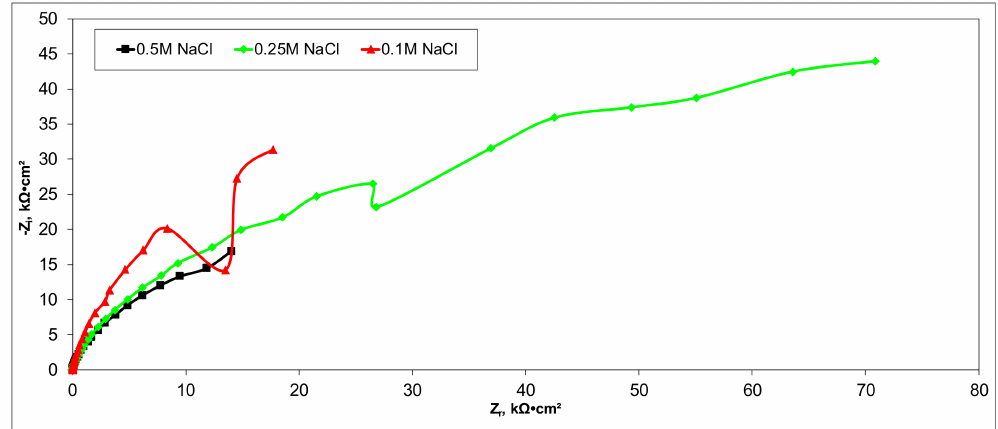
Figure 12. Nyquist plots for the X2 variant in NaCl: 0.5M, 0.25M,